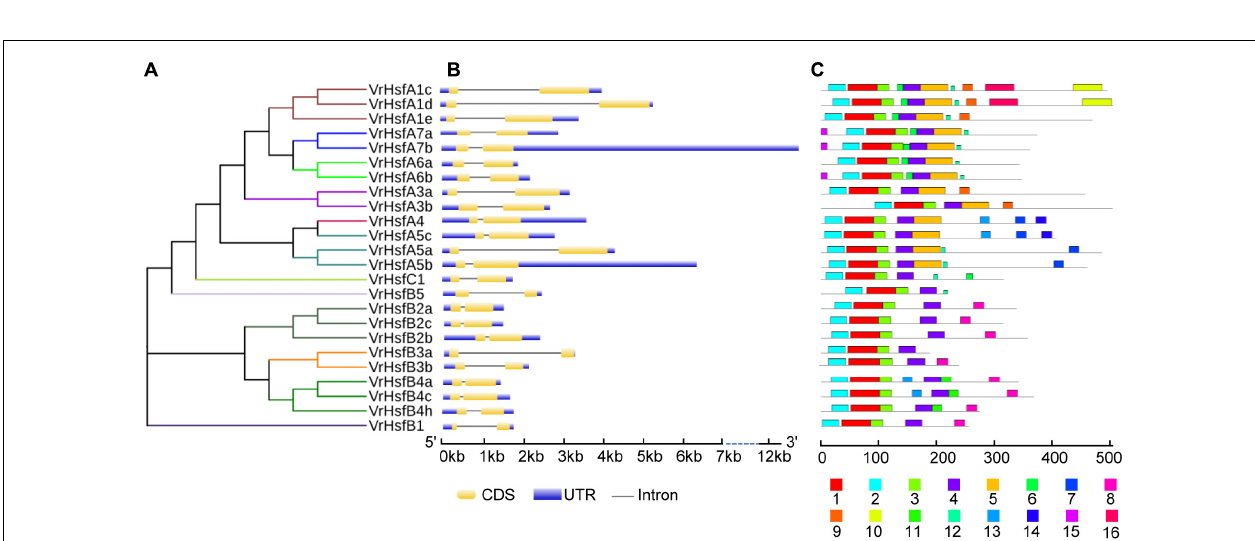
FIGURE 2 | Phylogenetic and structure analysis of VrHsf genes. (A) The conserved domains of VrHsf proteins were used to construct the phylogenetic tree. (B) The exon/intron distribution of VrHsf genes were analyzed by comparing coding sequences with genomic sequences. The UTRs, exons and introns are represented by blue, yellow and black lines, respectively. (C) Motifs in VrHsf proteins identified by MEME. The motifs, numbered 1–16, are exhibited in different colored boxes.